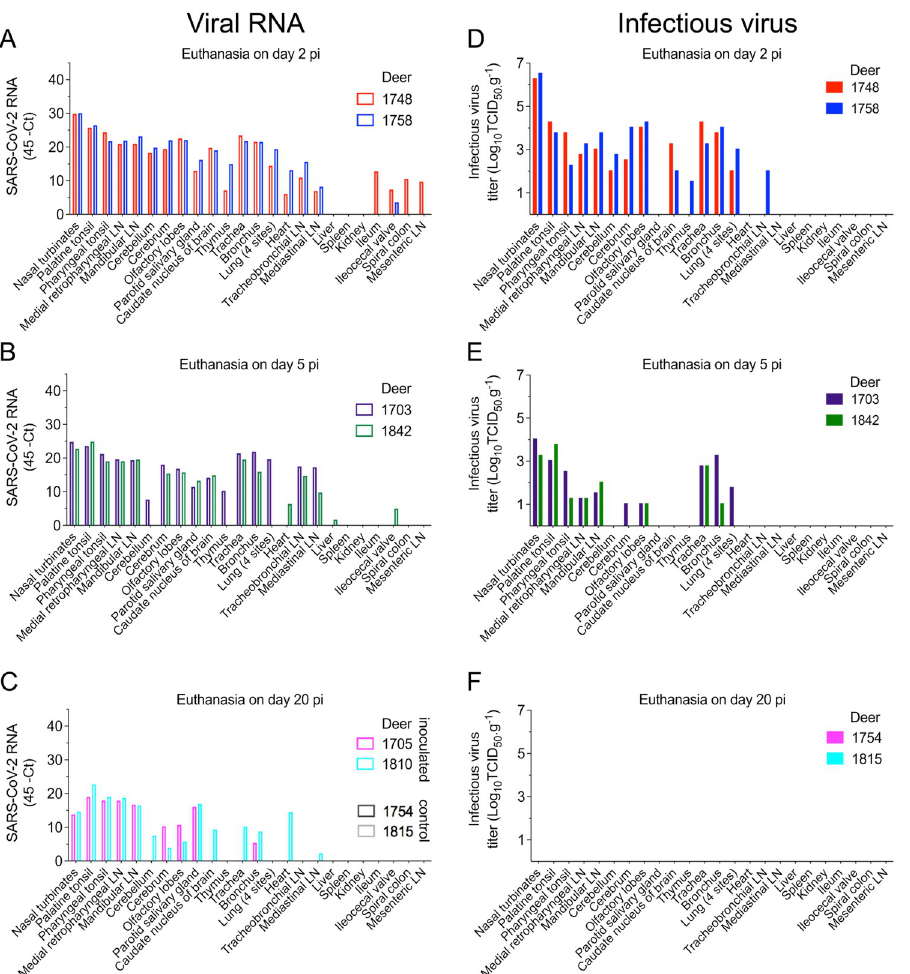
Fig 6. Tissue distribution of SARS-CoV-2 RNA and infectious virus in white-tailed deer. Tissues were collected and processed for real-time reverse transcriptase PCR (rRT-PCR) and virus titrations. A - C ) Tissue distribution of SARS-CoV-2 RNA assessed in twenty-four tissues collected and processed for rRT-PCR in deer on days 2 ( A ), 5 ( B ), or 20 post-inoculation (pi) ( C ). D - F ) Infectious SARS-CoV-2 in tissues assessed by virus titrations in RT-rPCR-positive samples obtained on days 2 ( D ), 5 ( E ) or 20 pi ( F ). Virus titers were determined using end point dilutions and expressed as TCID 50 .ml -1 . All the controls fawns (uninoculated) remained negative through the experimental period. as medial retropharyngeal- and mandibular lymph nodes (Fig 6C). All tissues from the con- trols animals (uninoculated) tested negative by rRT-PCR (Fig 6C). Replication of SARS-CoV-2 was investigated in rRT-PCR positive tissues by viral titrations. Notably, infectious virus was consistently detected in a broad range of tissues on days 2 and 5 pi including nasal turbinate, tonsil (palatine and pharyngeal), lymph nodes (medial retrophar- yngeal, mandibular and tracheobronchial) and/or in the low respiratory tract tissues (trachea, bronchus and lung). Interestingly, infectious virus was also detected in olfactory lobe, caudate nucleus of brain, cerebrum, and cerebellum in both deer euthanized on day 2 pi (Fig 6D). On day 2 pi, viral titers ranged from 1.5 to 6.5 log10 TCID .g -1 (Fig 6D), with the highest viral 50 loads detected in the nasal turbinate of the two animals euthanized on day 2 pi (6.3 and 6.5 log10 TCID .g -1 ) (Fig 6D). On day 5 pi, infectious virus was detected in 8 out of 24 tissues in 50